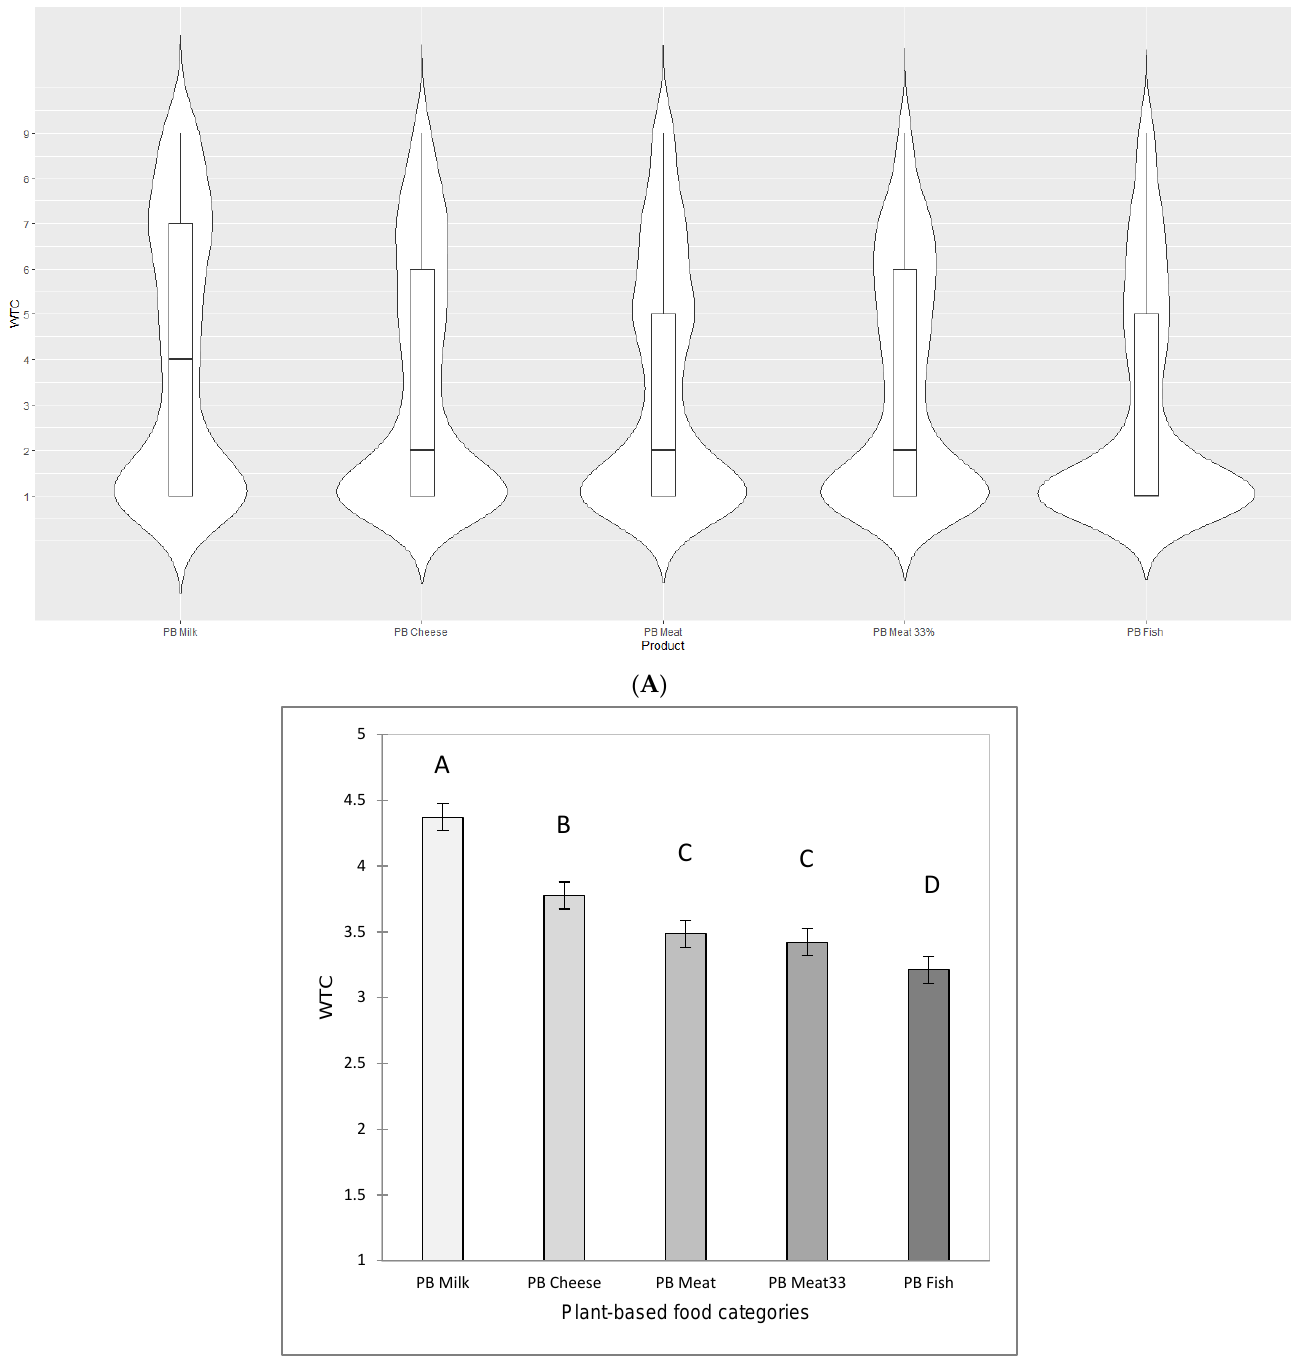
Figure 1. Mean willingness to consume (WTC) ratings for aggregate sample across 2494 consumers in USA, Australia, Singapore and India shown for the five plant-based (PB) food categories included in the research. ( A ) Violin plot of WTC ratings for PB food categories, with median and interquartile range; ( B ) Mean WTC ratings, with standard error. WTC was measured on a 9-point scale (1 = ’Never or less than once yearly’, 5 = ‘ 1 – 3 times per month’, 9 = ‘Once daily or more’). In ( B ), PB food categories with different letters following Tukey’s post hoc test are significantly different at the 5% level of significance.